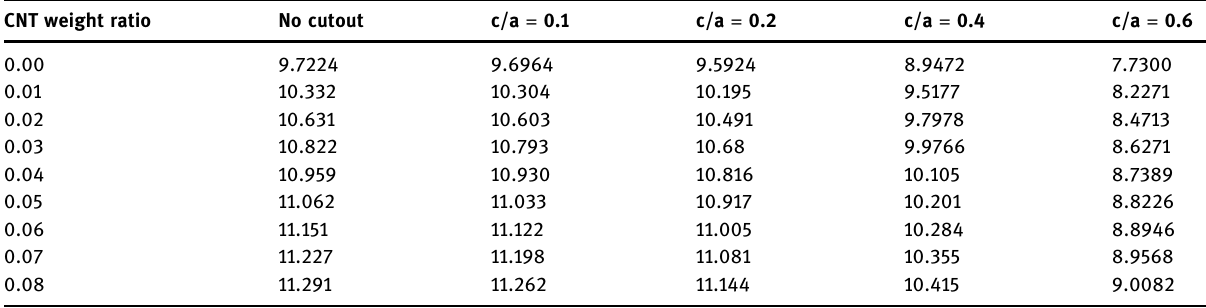
Table 6: Natural frequencies of CNTFPC fl at panels with and without cutout for increased SWCNT weight ratios CNT weight ratio